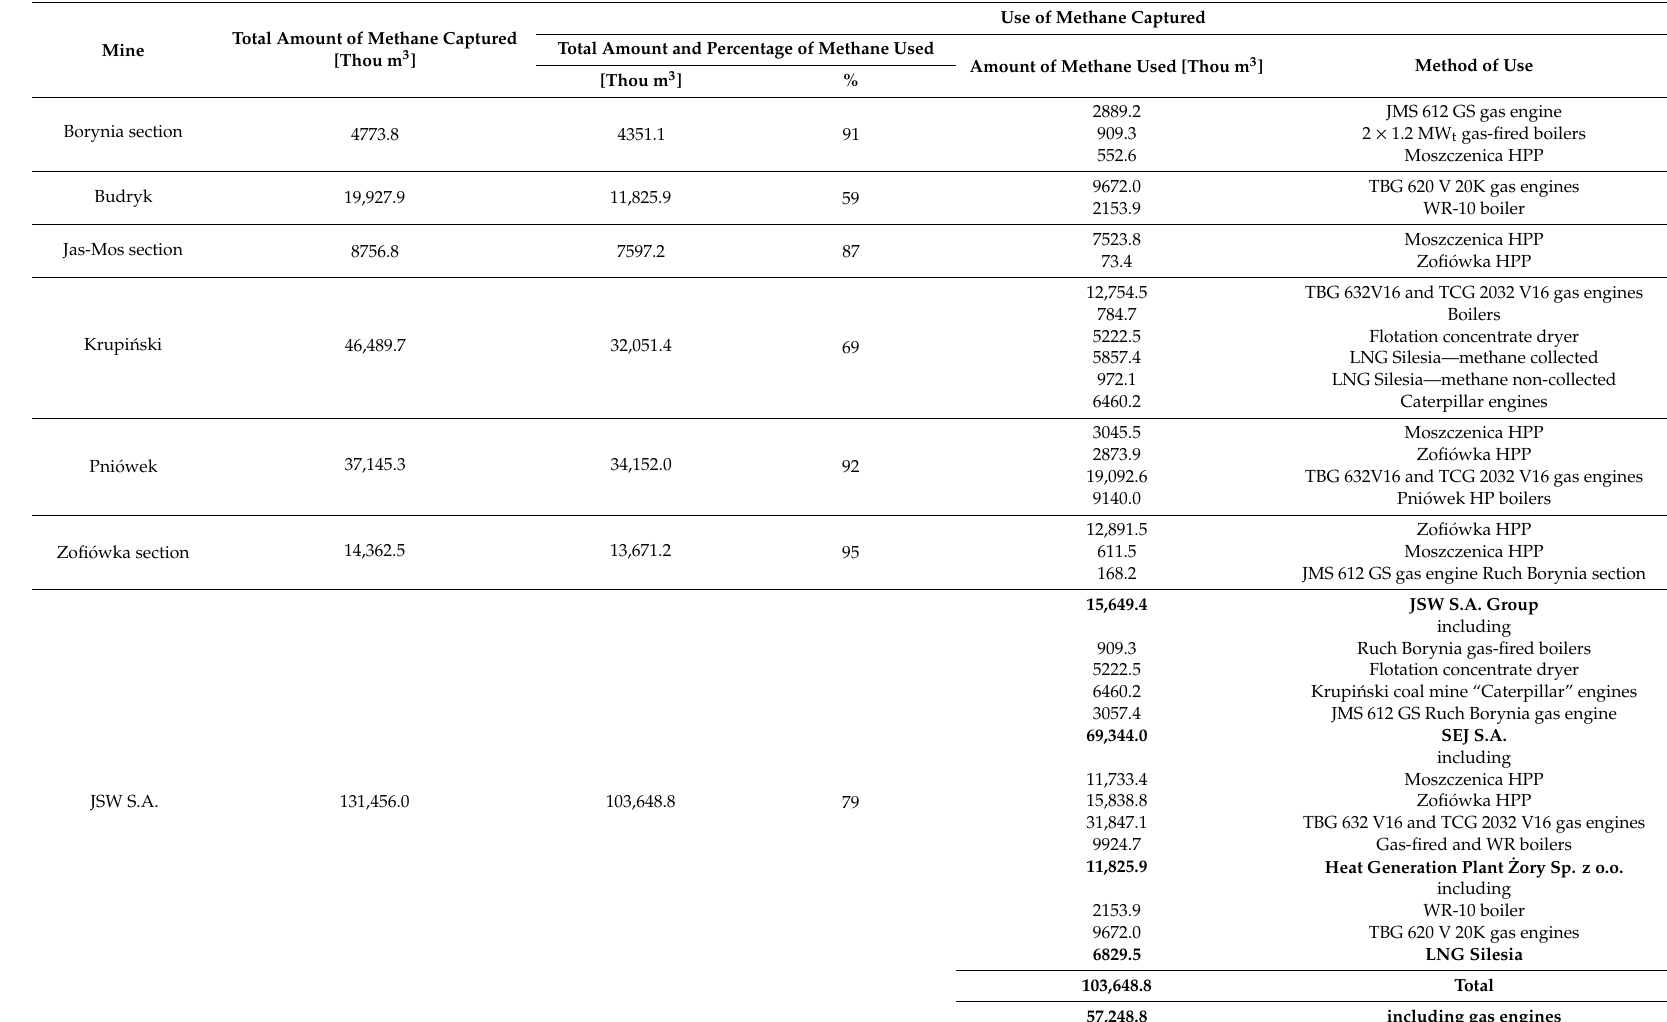
Table 1. The use of captured methane in JSW S.A. in 2017